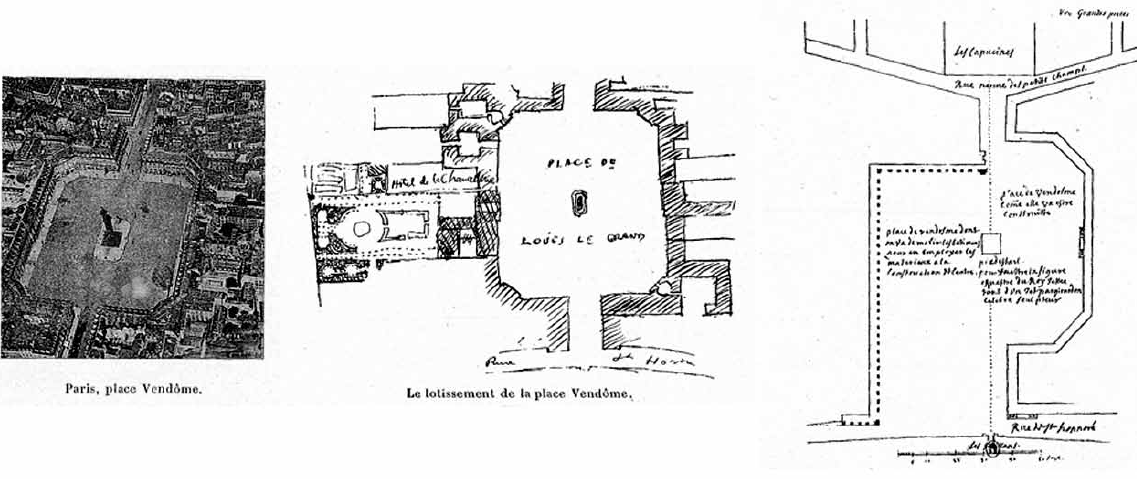
fig. 22. Images of Place Vendôme in Urbanisme . ©